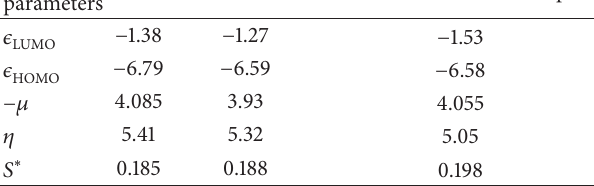
Table 2: Reactivity descriptors for the complex resulting from the interactions between 5-FU and the human body generated 5-F-2 󸀠 - dUMP (values are in